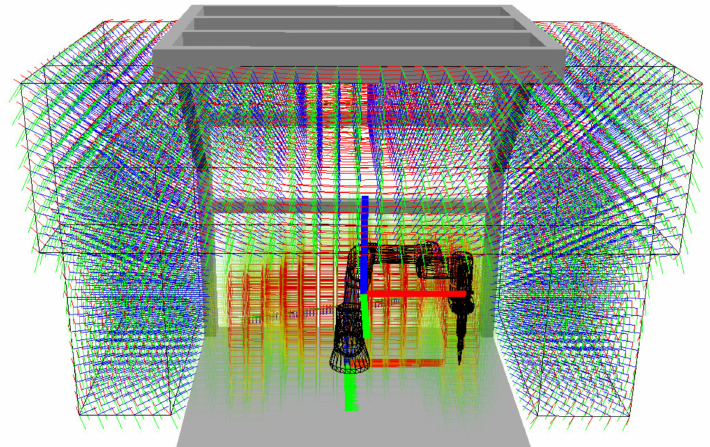
Figure 15. Position and orientation of all possible cameras monitoring the